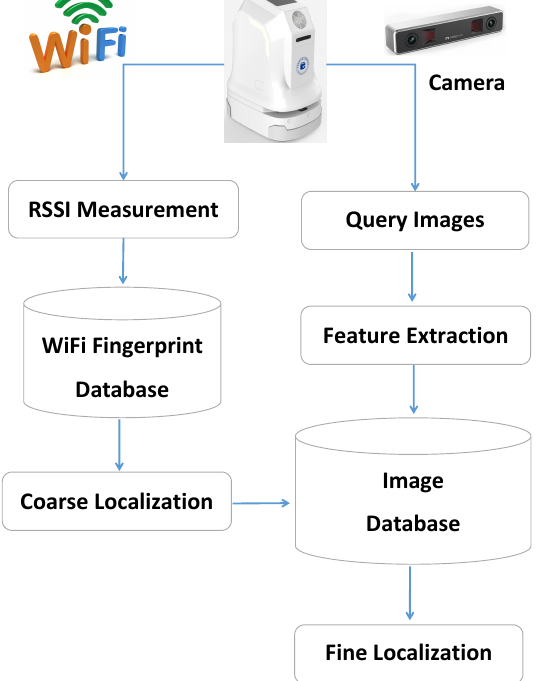
Figure 2. The overall procedures of the proposed JVWL scheme. It contains two stages, including WiFi RSSI-based coarse localization and visual-image-based fine